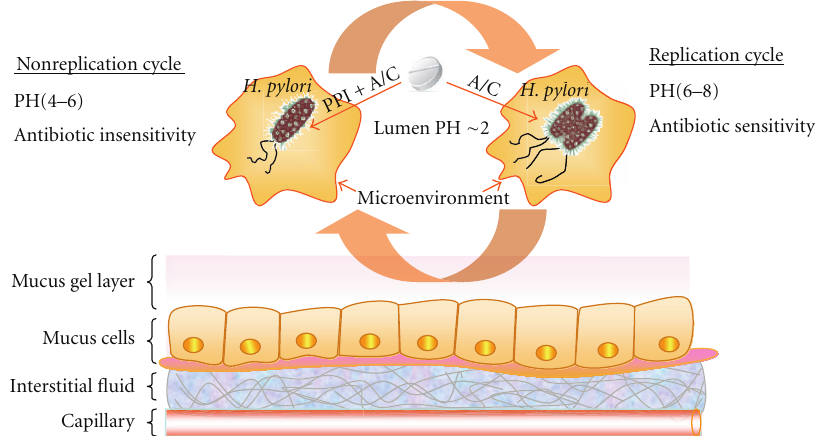
Figure 1: H. pylori oscillates between a replicating state (antibiotic sensitivity) and nonreplicating state (antibiotic insensitivity) according to the pH in the microenvironments, and PPI synergizes with the antibiotics by e ff ectively increasing gastric pH and disrupts the acidic environment preferred by HP. PPI: proton pump inhibitor, A: amoxicillin, C: